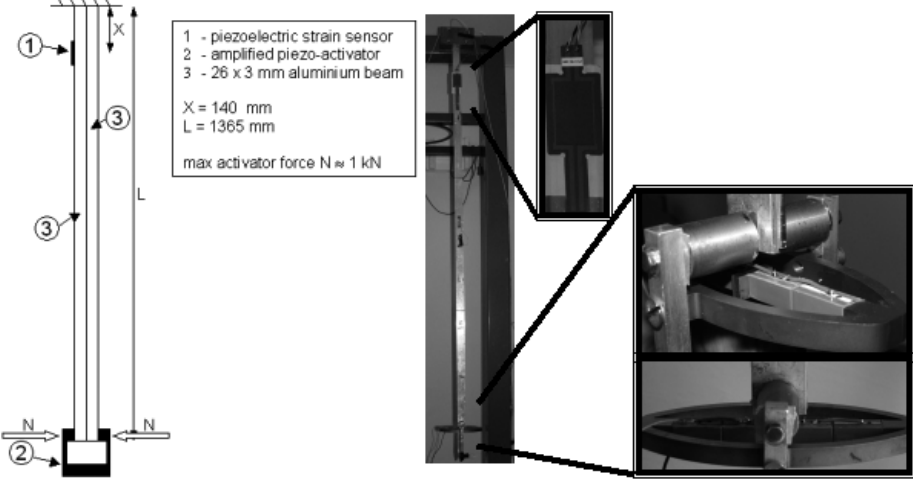
Fig. 13. Experimental set-up, detailed view of sensor and